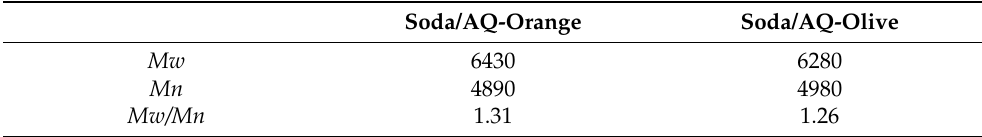
solubilized olive lignin recovered from soda/AQ black liquor.